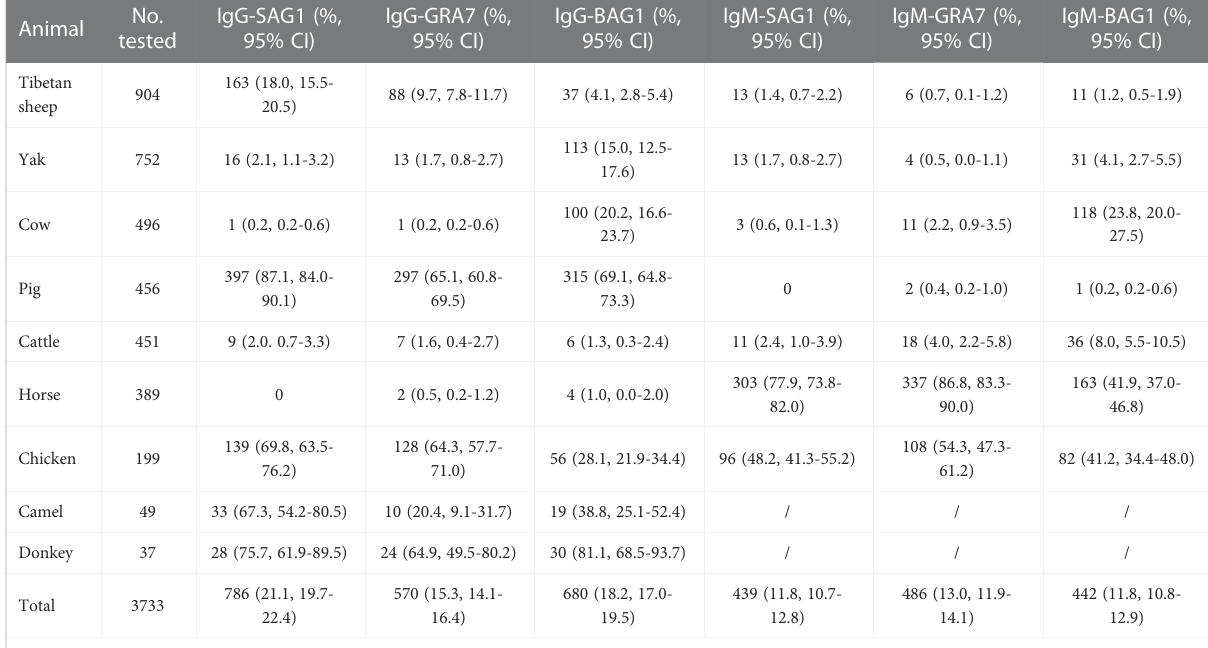
TABLE 1 Seroprevalence of speci fi c- T. gondii IgG and IgM antibodies in various animals. No. Animal Tibetan sheep